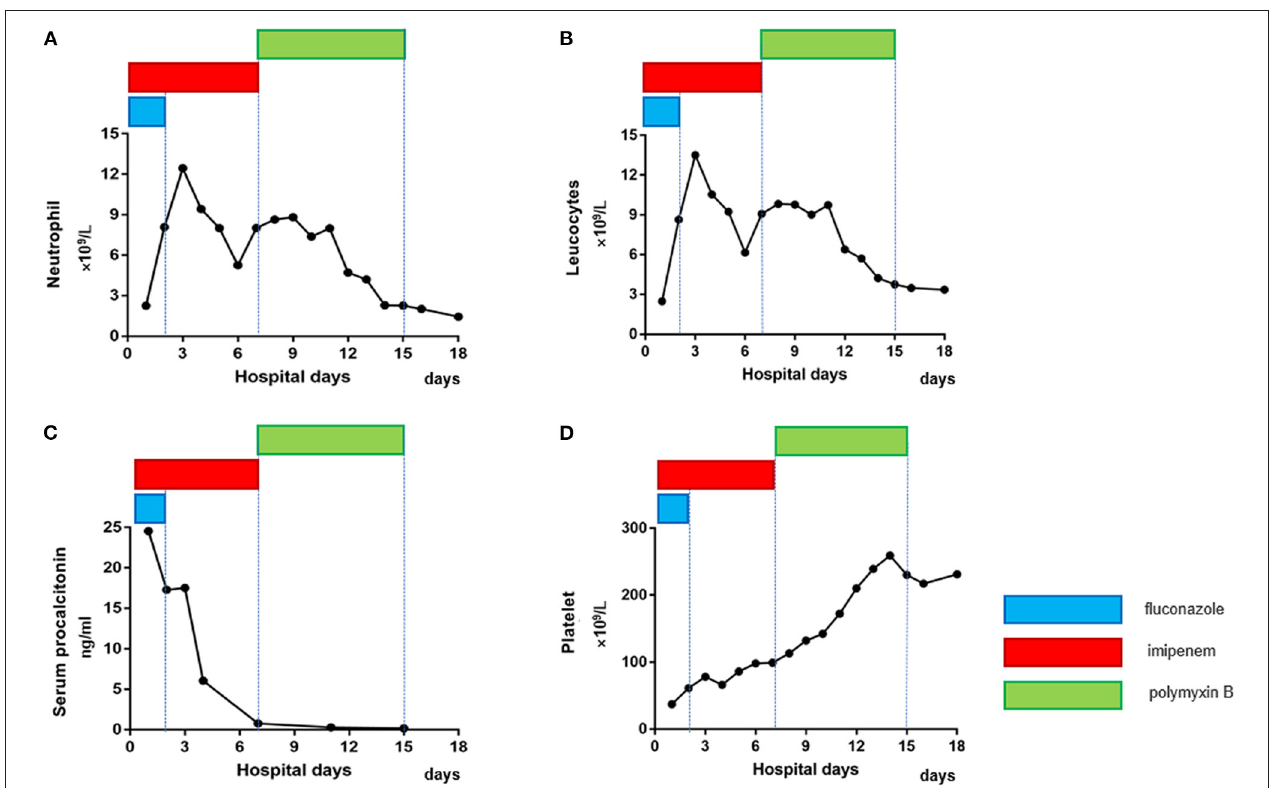
FIGURE 3 | Dynamic changes in infection indexes and platelet counts in the patient after admission. (A, B) The neutrophil and leucocyte counts decreased significantly 7 days after admission. (C) The serum procalcitonin level continued to decline. (D) The platelet count continued to increase. Eventually, the patient’s indicators returned to normal (different colors represent different medications, and the length of the lines represents the duration of treatment with the